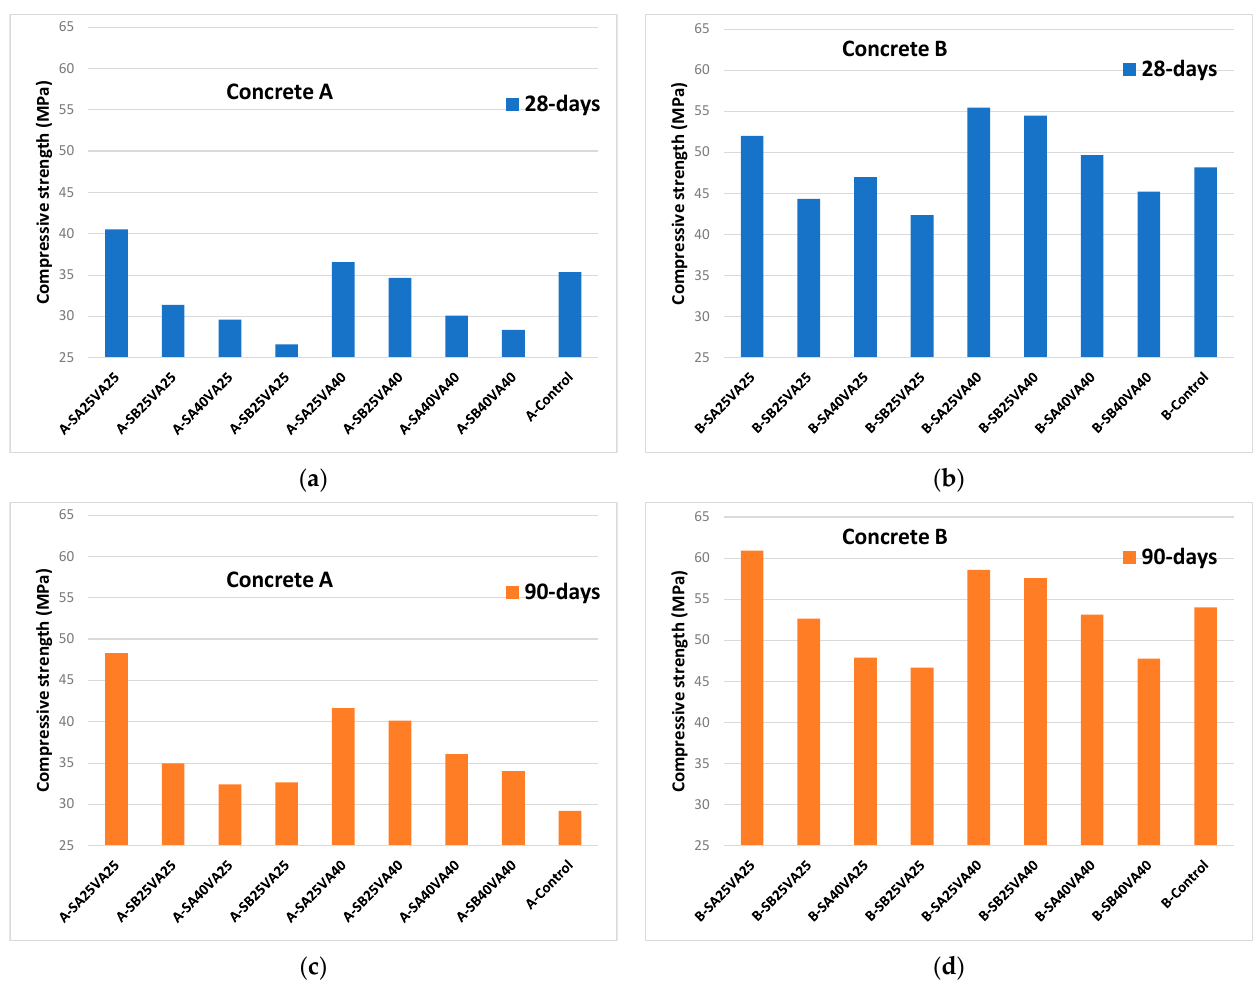
Figure 1. Compressive strength at 28- and 90-days (MPa): ( a ) concrete A at 28-days; ( b ) concrete B at 28-days; ( c ) concrete A series at 90-days, and ( d ) concrete B series at 90-days.